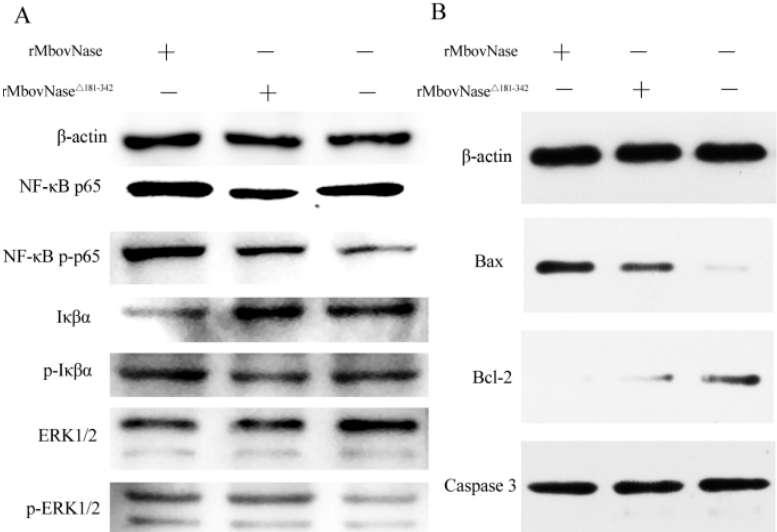
Figure 8. Effects of rMbovNase and rMbovNase Δ 181–342 on expression of NF- κ B p65, MAPK ERK1/2, Bax, Bcl-2 and Caspase 3 in BoMac cells. ( A ) The expression of signal transduction molecules associated with NF- κ B signal transduction pathway; ( B ) The expression of apoptosis-related proteins. Western blot analysis of total protein extracts was performed for each group after 1 μ M rMbovNase or rMbovNase Δ 181–342 treatment at 37 °C for 24 h. Commercial antibodies specific to the listed proteins were used, while β -actin was taken as the internal reference.